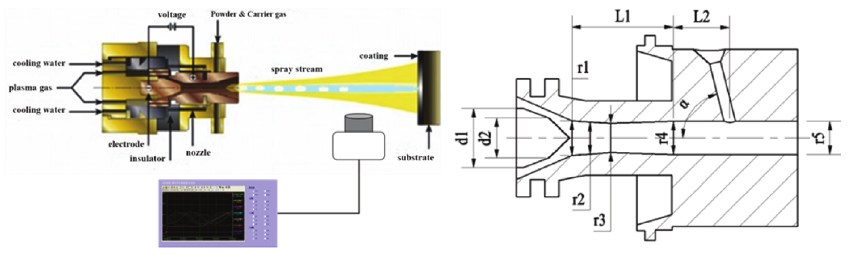
Figure 2: The high efficiency supersonic atmospheric plasma spraying (SAPS) system (a) the scheme of experiment, (b) the structure of spraying gun.